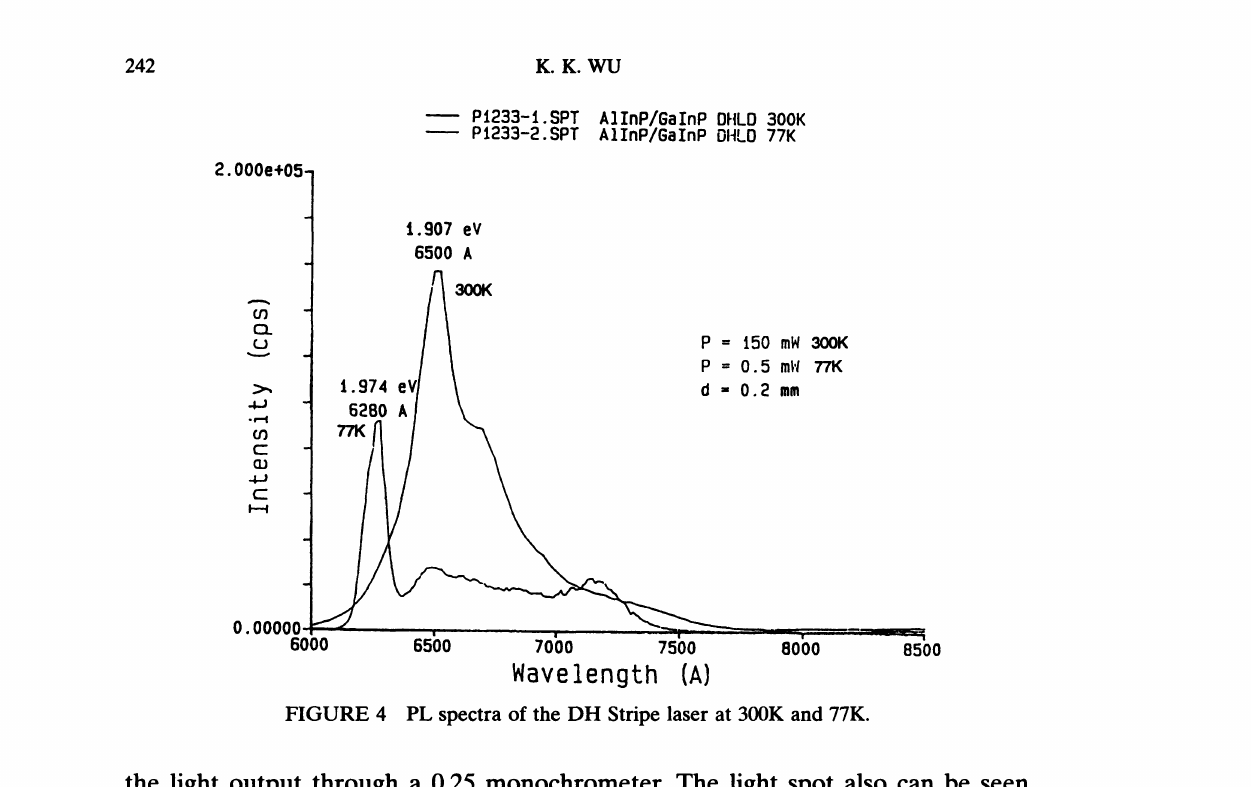
FIGURE 4 PL spectra of the DH Stripe laser at 300K and